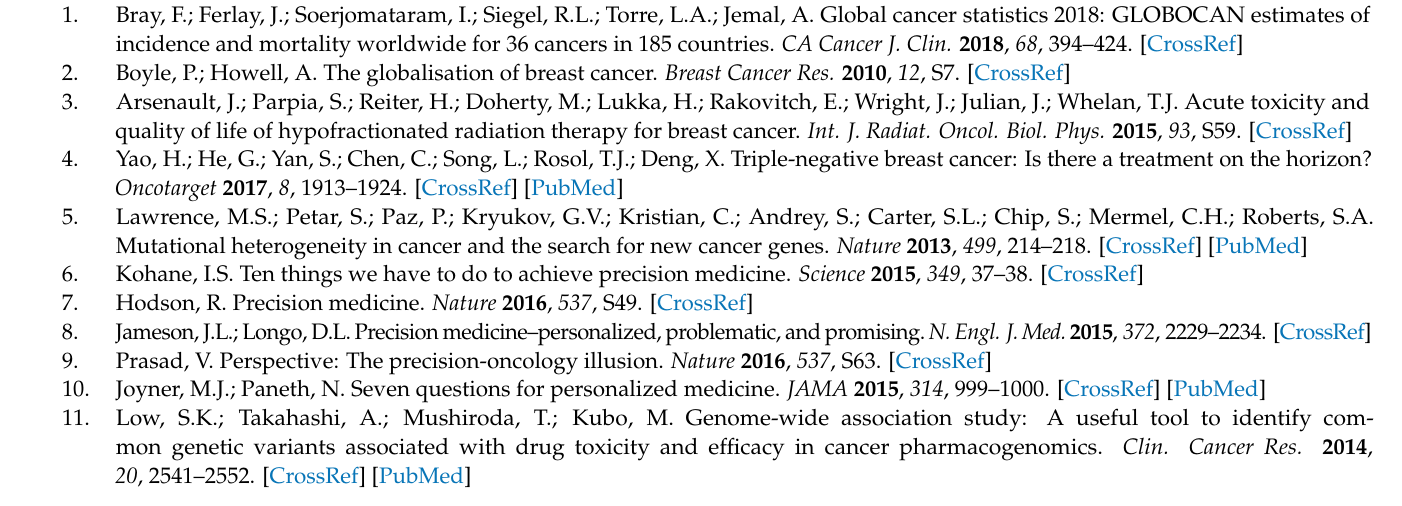
of OV, Table S4: Gene dependency network related to the prognosis of GBM, Tables S5 and S6:The enriched pathways of essential genes in OV and GBM, Table S7: Drug combinations prediction for specific